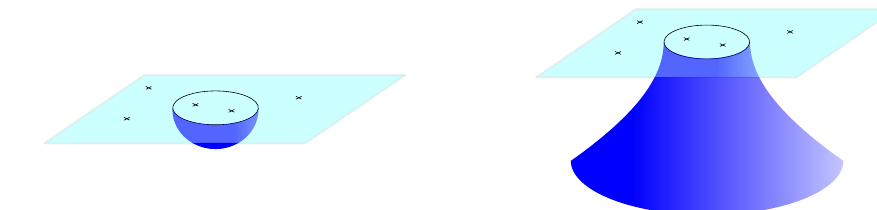
Figure 8 . Hemisphere in EAdS and its analog in dS. Left : by performing a path integral inside the hemisphere (the thick blue surface), we can replace the effect of insertions inside the hemisphere with a wave function defined on the surface. This establishes the state-operator correspondence. Right : on the other hand, an analog of the hemisphere in dS is given by a hyperboloid, which is non-compact and time-like. Therefore we cannot define a wave function on the surface in the standard sense.